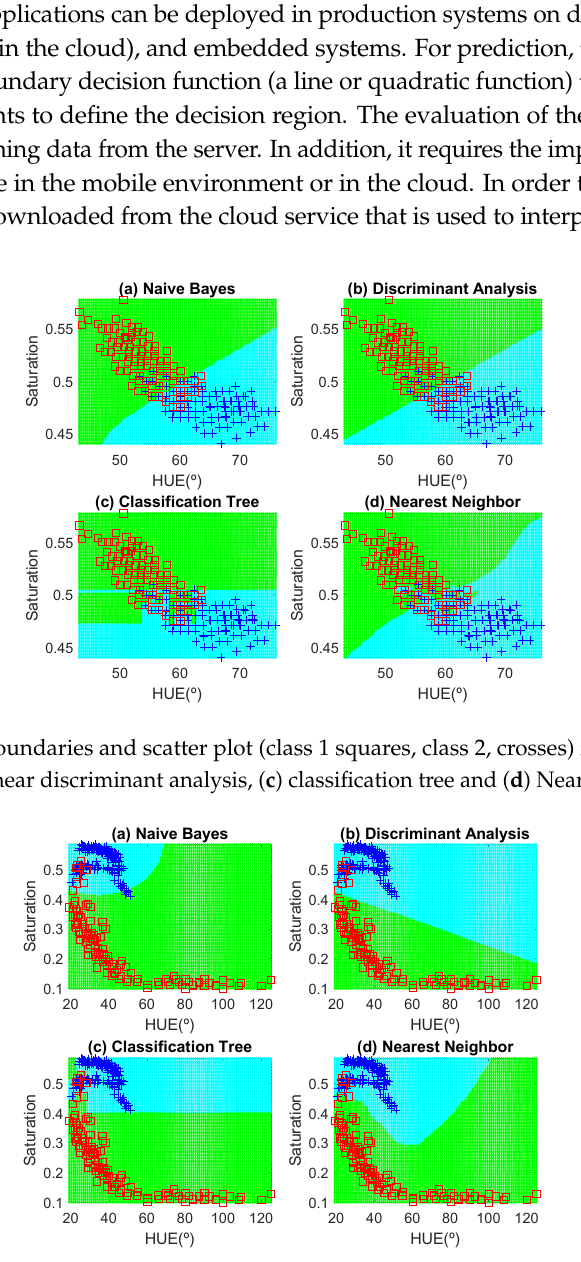
Figure 13. Decision boundaries and scatter plot (class 1 squares, class 2, crosses) for the banana. ( a ) Naive Bayes, ( b ) linear discriminant analysis, ( c ) classification tree and ( d ) Nearest Neighbor (k=5).